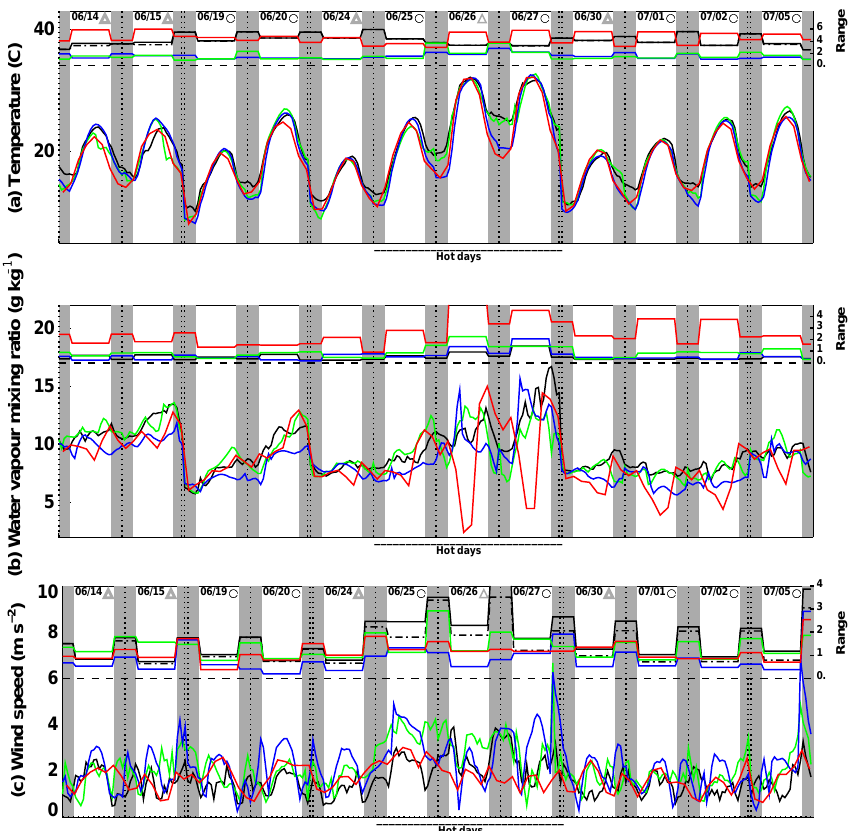
Figure 5. Time series of 24h sequences for the 12 IOPs of (a) 2m temperature, (b) 2m water vapour mixing ratio and (c) 10m wind speed, measured over several surfaces in black, simulated by ARPEGE in blue, by AROME in green and ECMWF in red with the mean value (left axis), and the maximum horizontal range (right axis, computed as the difference between the maximum value and the minimum value for all sites or all grid points of a given model but averaged respectively over day and night). The vertical grey shading marks the night-time. Two consecutive vertical dashed lines indicate interruption in the days. Note that for ARPEGE, due to the different behaviour of ARP1 and ARP3, only ARP2 is plotted as the mean while the spatial variability is computed with the three points.